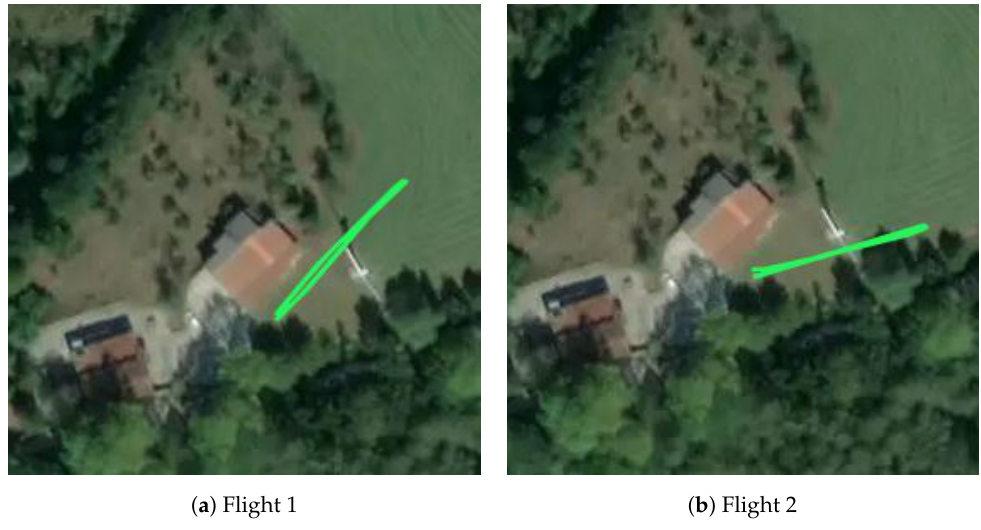
Figure 10. Horizontal trajectory of each flight in the outdoor